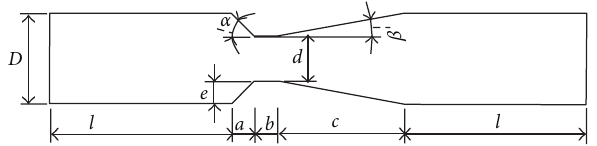
Figure 1: Structural diagram of Venturi injector.